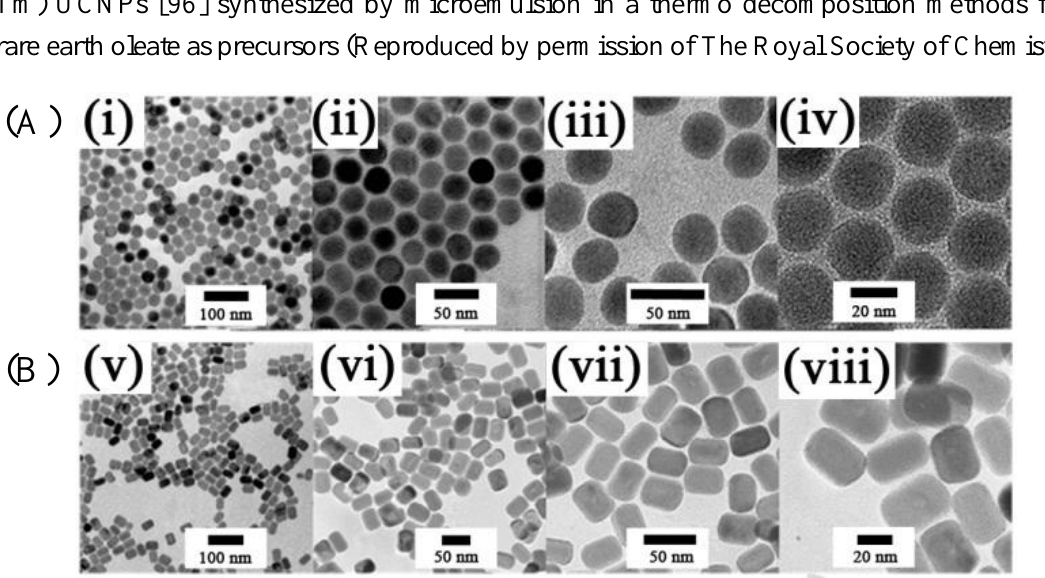
Figure 6. (i–viii) TEM images taken with different magnifications of: ( A ) β-NaYF Er 3+ (Tm 3+ ) [95] and ( B ) β-NaGdF